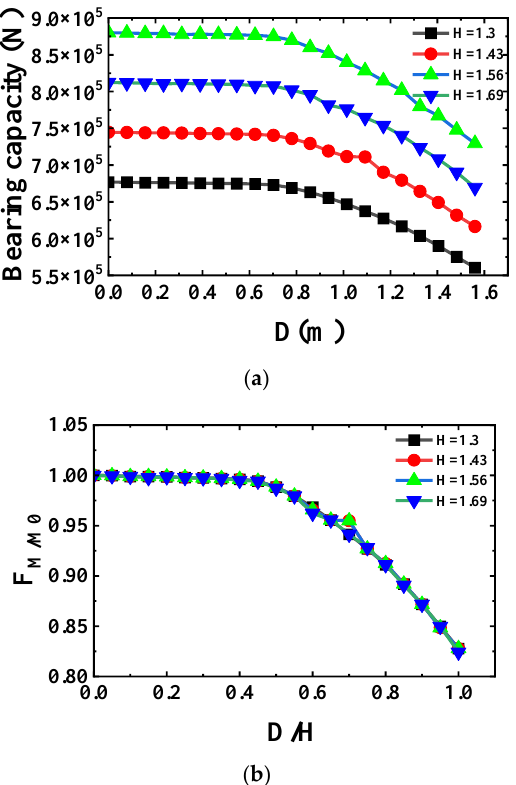
Figure 19. Relationship between mooring point height and carrying capacity. ( a ) Sensitivity analysis of mooring point height to bearing capacity; ( b ) Dimensionless relationship between mooring point height and bearing capacity.